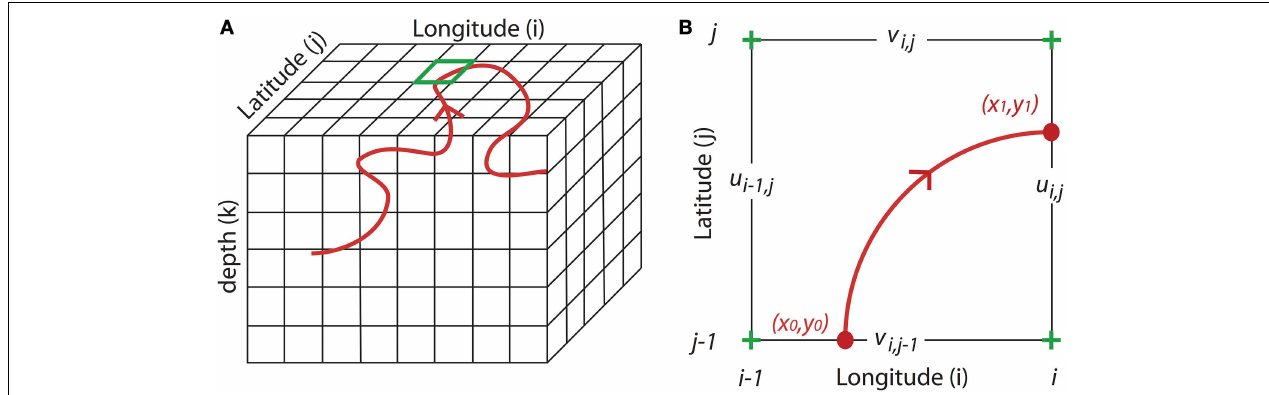
FIGURE 1 | Principles of the combined Eulerian-Lagrangian approach. (A) Schematic of a random Lagrangian trajectory (red line) driven by the Eulerian current ( u,v,w ) in a three-dimensional grid model. (B) Details of the green box in (A) , showing a Lagrangian computation in the horizontal plane ( w = 0 ) (Döös et al., 2013).